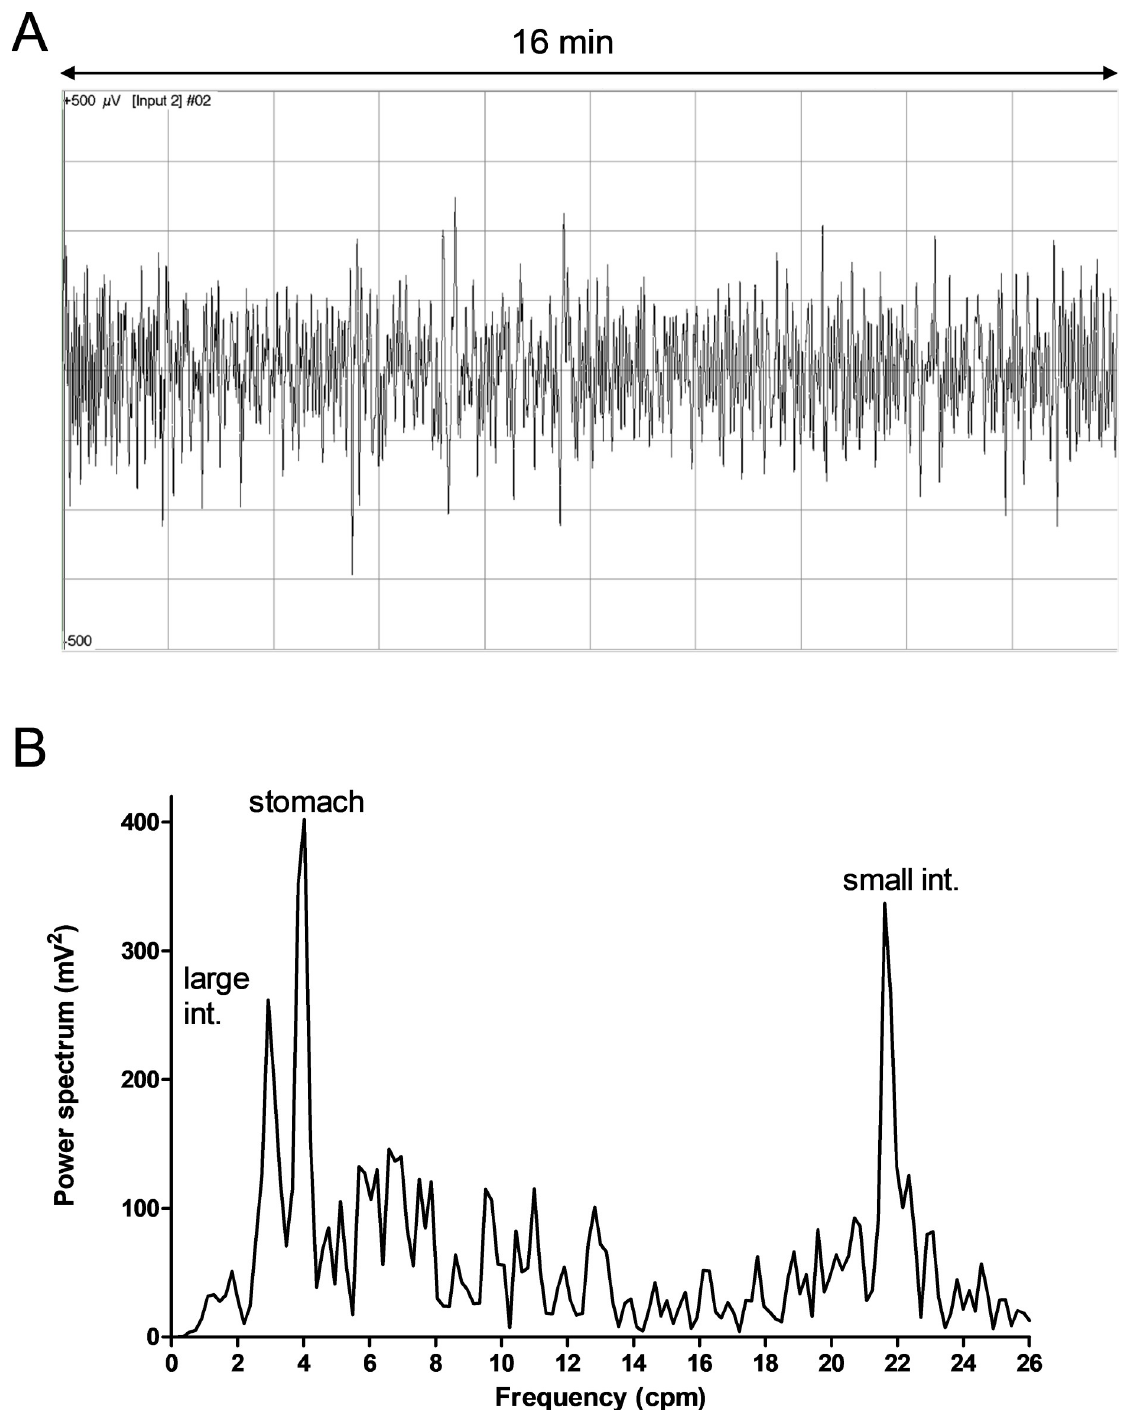
Fig 3. The primary myoelectric signal of the gastrointestinal tract in a non-anaesthetised, free-moving pig (A), and the specific spectra (B) gained by fast Fourier transformation (FFT) showing three dominant peaks particularly notable between 1–3, 3–5 and 20–25 cpms for the large intestine, stomach and small intestine, respectively. The heights of the peaks are the PsD max values that were compared to characterise the changes in the intensities of the given GIT segments caused by the different fibre contents of the feeds.